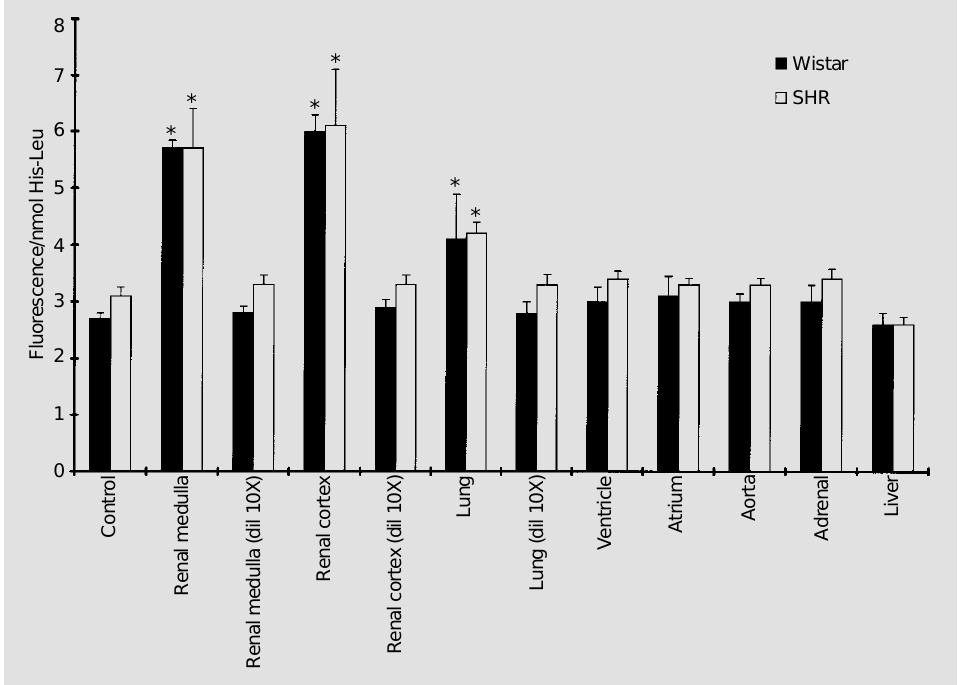
Figure 1 - Influence of tissue ho- mogenates on the fluorescence of the dipeptide His-Leu. The flu- orescence of the dipeptide His- Leu was compared in the pres- ence and absence of the homog- enate (25 µl). Results are ex- pressed as fluorescence/nmol His-Leu. Data represent the mean ± SD of three independ- ent experiments for SHR (open columns) and Wistar rats (filled columns). *P<0.001 compared to control (Student t